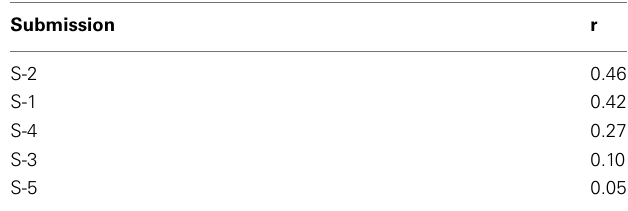
Table 5 | (Data Set 4). Performance of the five